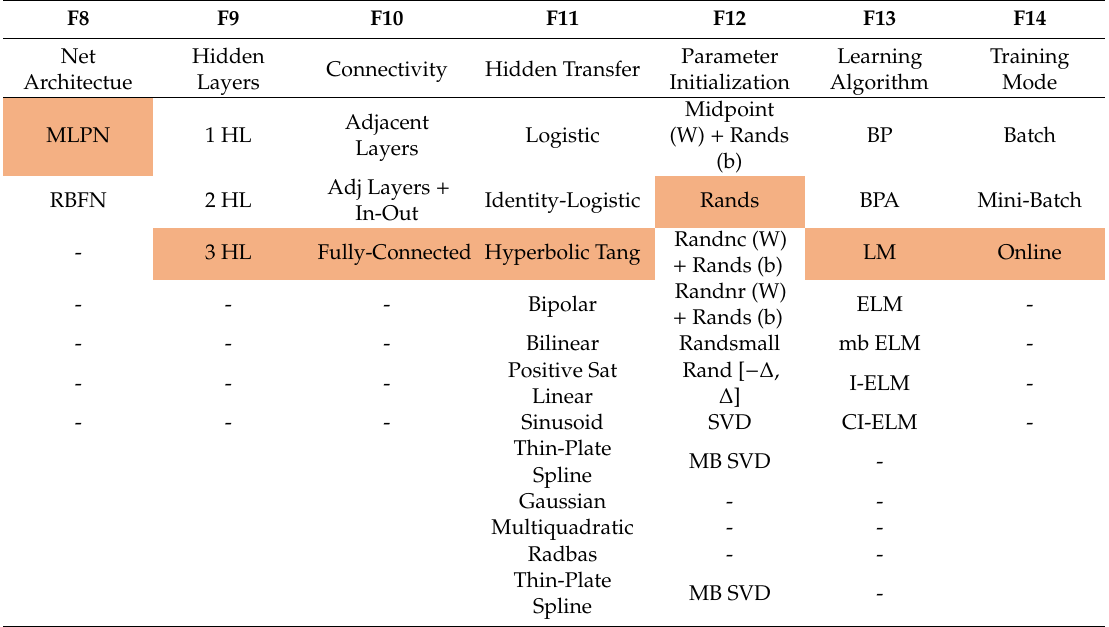
Table 4. Implemented ANN features (F) 8–14. The highlighted cells show the features that were used to derive the final neural